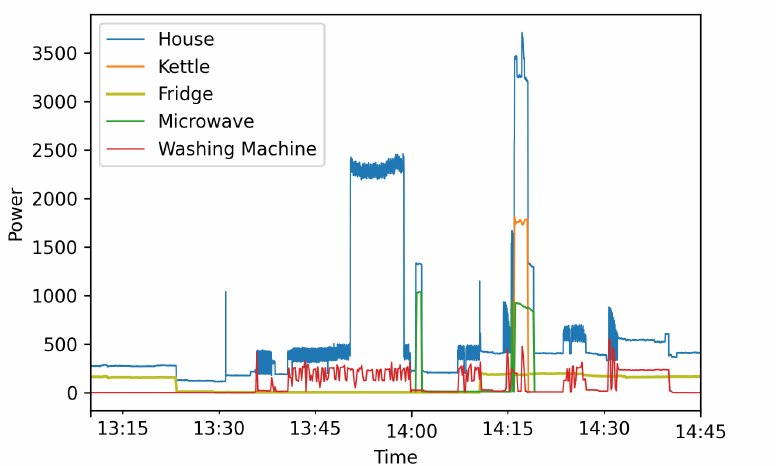
Figure 12. Power consumption data from the four appliances using smart plugs and the main load of the